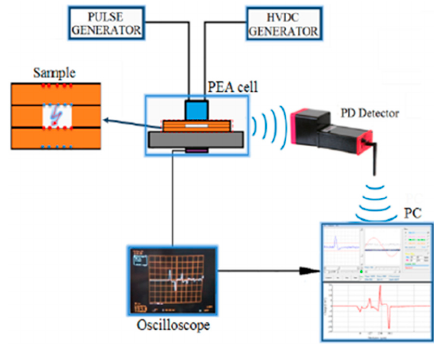
Figure 19. The measurement setup for the simultaneous detection of the space charge and partial discharges.